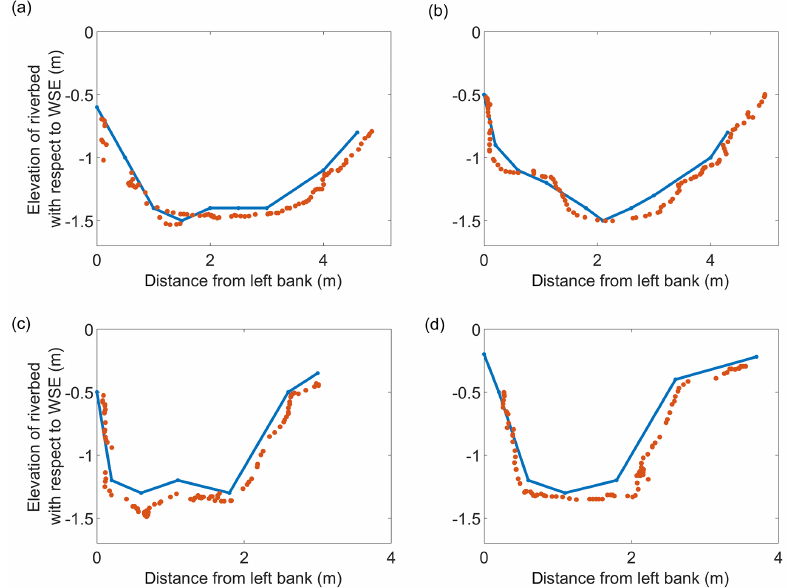
Figure 10. River cross sections retrieved at different locations along Marrebæk Kanal. The y axis shows the difference between riverbed elevation and WSE (opposite sign of water depth). Red points are retrieved with UAV-borne observations and blue lines are the ground truth observations. The latitude and longitude coordinates of the left bank of the river cross sections are (a) 54.676300, 11.913296 ◦ ; (b) 54.675507, 11.913628 ◦ ; (c) 54.682117, 11.911957 ◦ ; and (d) 54.681779, 11.910723 ◦ (WGS84 reference